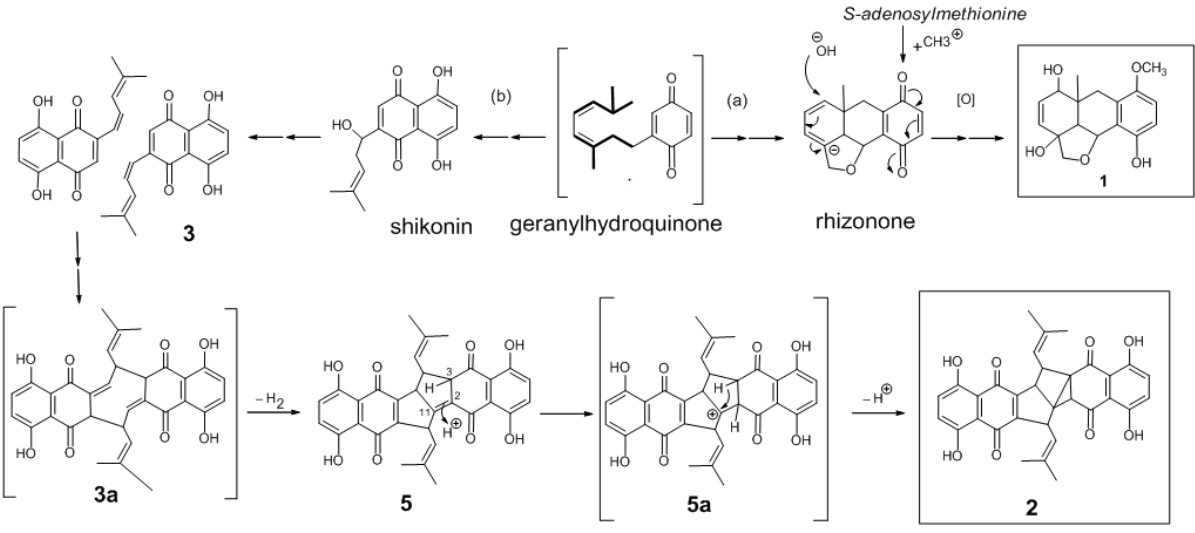
Figure 5. Proposed biosynthetic pathways for 1 and 2